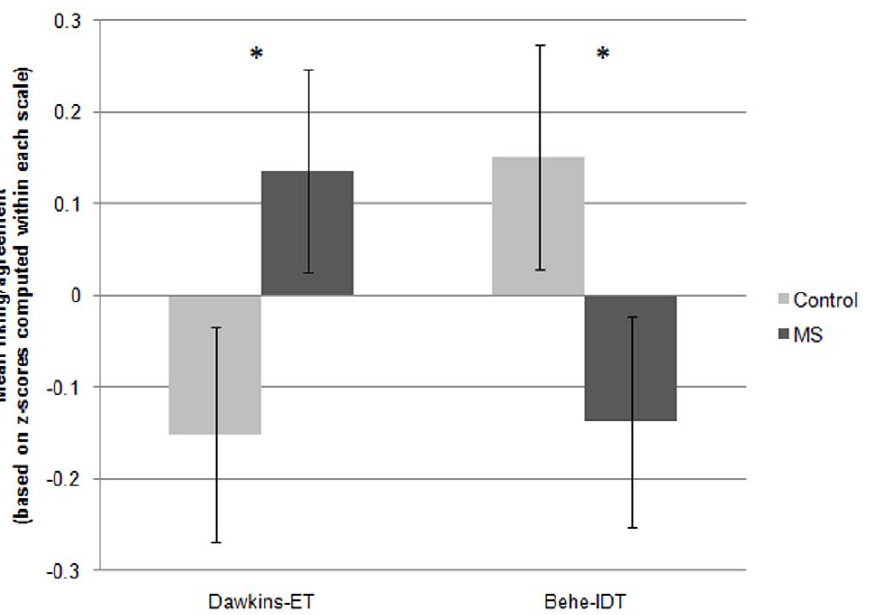
Figure 5. Effects of MS on liking of Behe and belief in IDT, and liking of Dawkins and belief in ET, in a sample of natural science students, Study 5. Note . Values are based on standard scores; means for each scale were computed by standardizing each of the six author-theory items that the scale comprised, around their common mean, and taking the mean of the resulting z-scores. Because the two scales were centered around different means, values on the two scales (Dawkins-ET and Behe-IDT) cannot be directly compared to each other. The overall interaction, based on a mixed-measures ANOVA, and the main effects on Dawkins-ET and Behe-IDT, based on t -tests, were significant, p s , .05 one-tailed. Error bars represent the standard error of the mean. * p , .05 one-tailed.